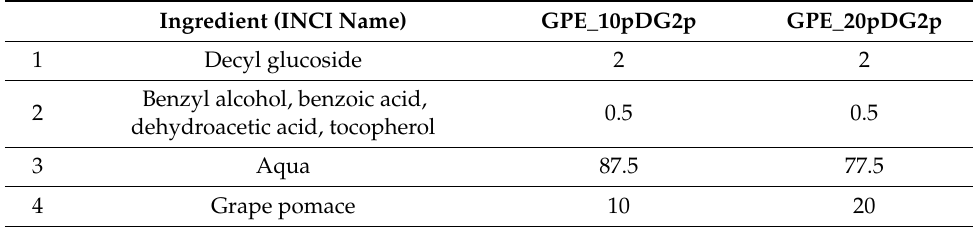
Table 7. The formulation used to prepare